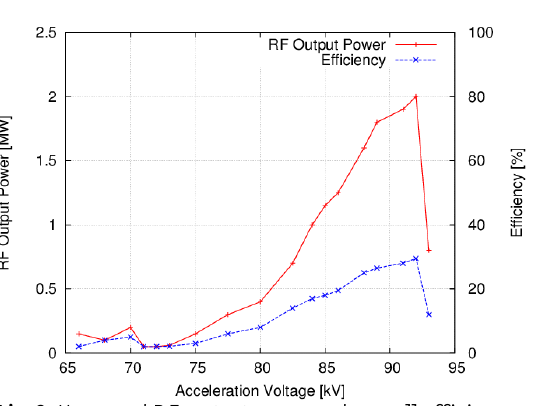
Fig. 2. Measured RF output power and overall efficiency as a function of the accelerating voltage U c (obtained at B cav = 6.87 T and I b ~75 A, operation without depressed